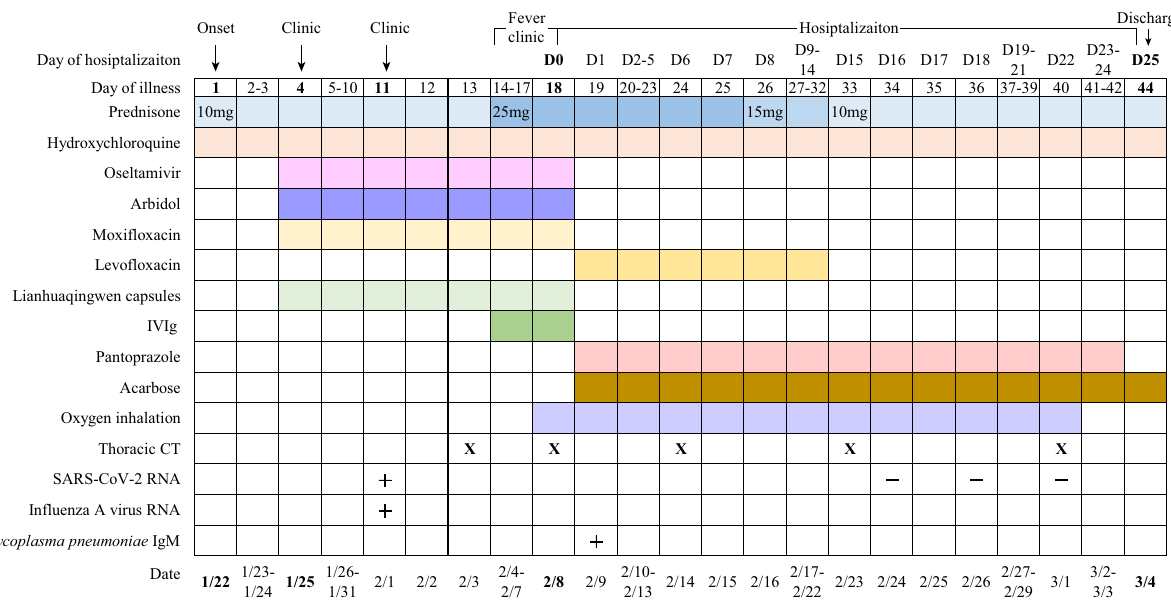
Figure 1: Treatments, radiology and pathogen fi ndings according to day of illness and day of hospitalization. Symbols: X, CT conducted; + , positive result; − , negative result. Abbreviations: IVIg, intravenous immunoglobulin; CT, computed tomography; SARS - CoV - 2, severe acute respiratory syndrome coronavirus 2; IgM, immunoglobulin